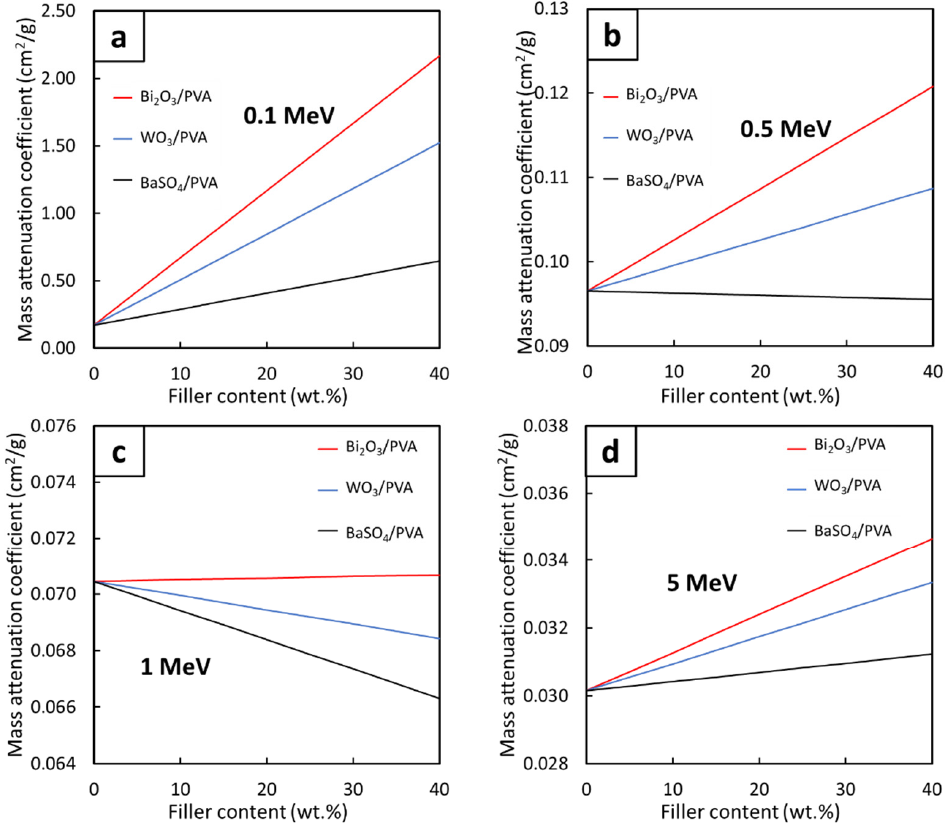
Figure 4. The µ m values of Bi 2 O 3 /PVA, WO 3 /PVA, and BaSO 4 /PVA hydrogels containing varying filler contents of 0–40 wt.%, determined at photon energies of ( a ) 0.1 MeV, ( b ) 0.5 MeV, ( c ) 1 MeV, and ( d ) 5 MeV using XCOM.